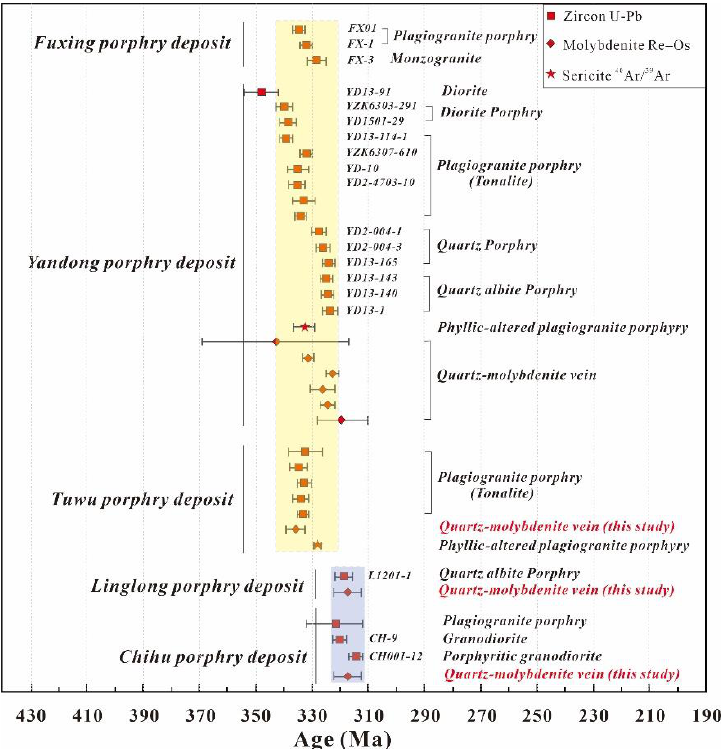
Figure 8. Summary of geochronological data of major porphyry Cu deposits in the Tuwu–Yandong belt. Error bars are 2σ.